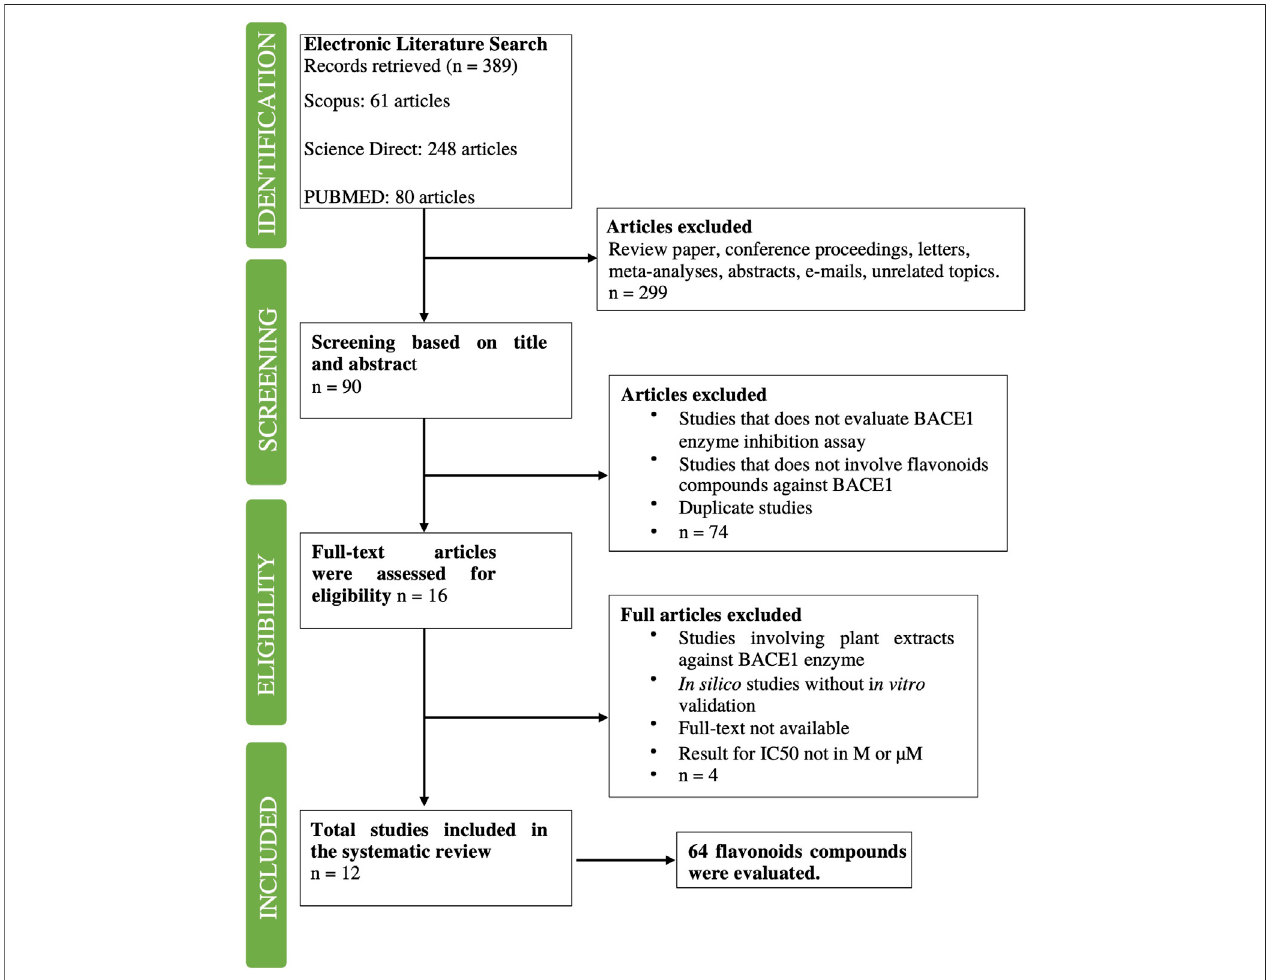
FIGURE 2 | Flowchart of the literature search conducted and number of articles fi ltered at each stage. The process is similar to that of a systematic review.